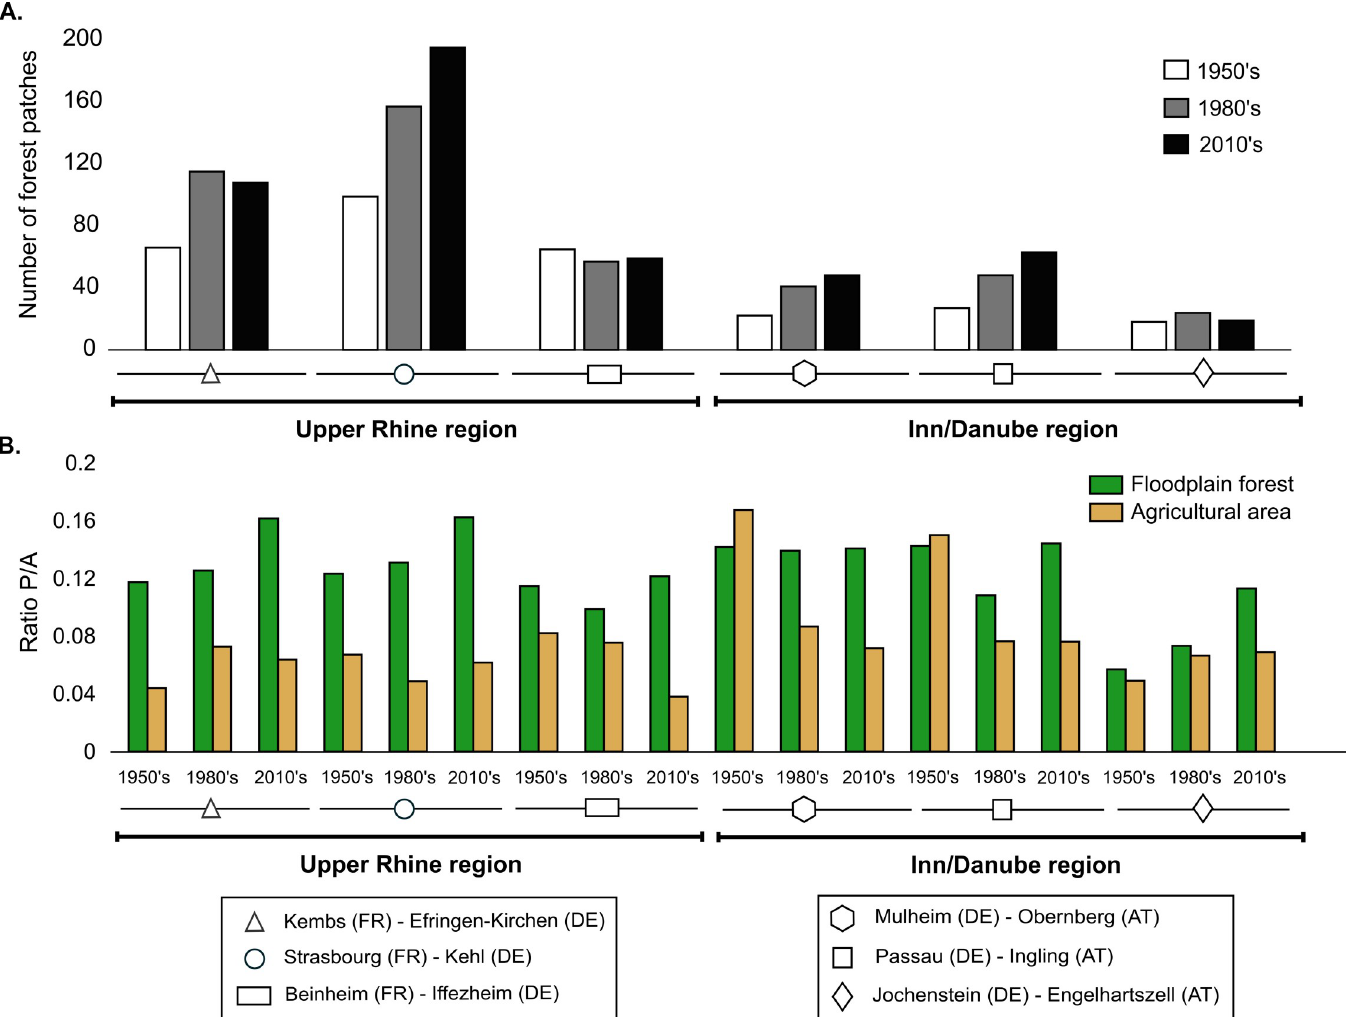
Fig 6. A. Number of relict floodplain forest patches for each study site and each time period; B. Forest and agricultural patch complexity, with the average Perimeter/Area ratio for patches of the same habitat